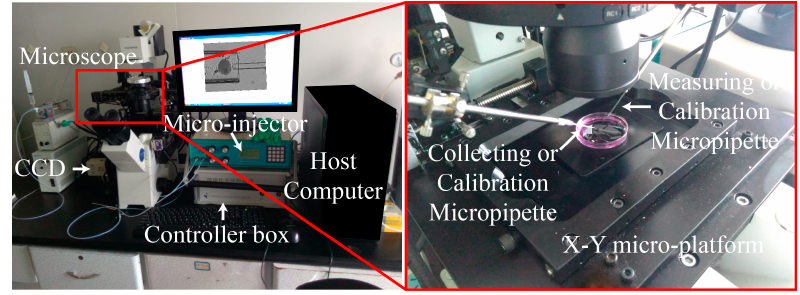
Figure 11. NK-MR601 micro-operation system.